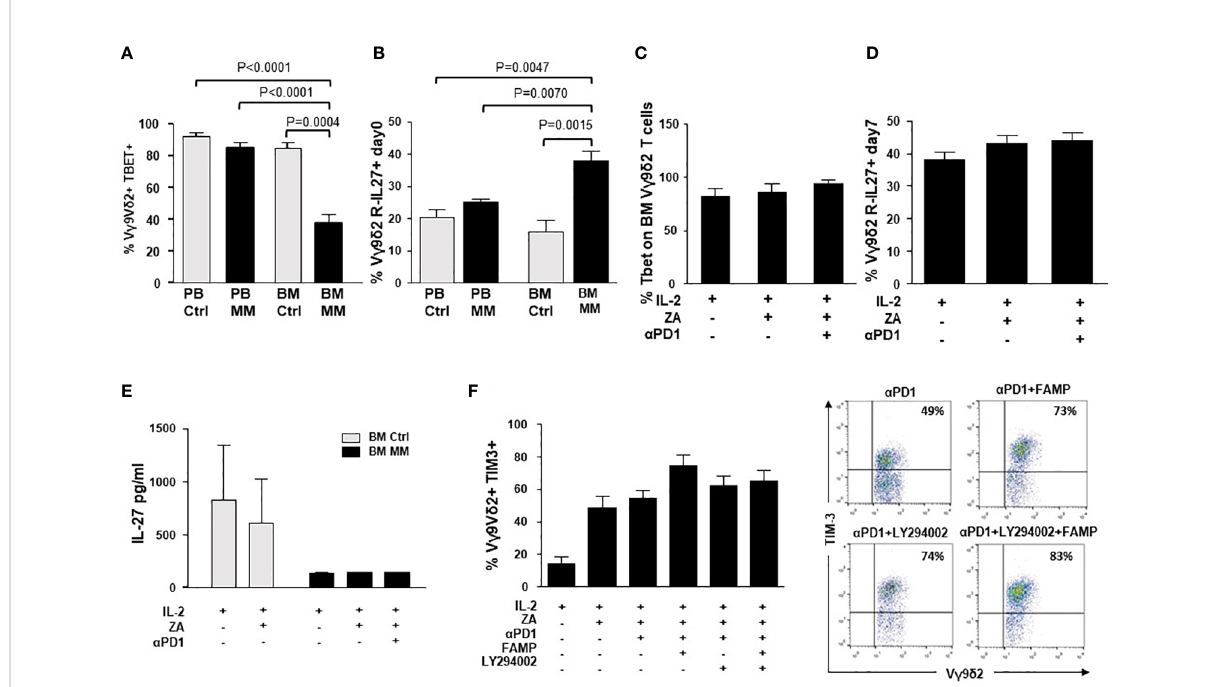
FIGURE 6 Intracellular PD-1/TIM-3 cross-talk is not mediated by the IL-27/pSTAT1/T-bet or PI3K-AKT axes. (A) T-bet and MFI expression in resting PB and BM Ctrl and MM V g 9V d 2 T cells. Bars represent the mean values ± SE from 6 (BM Ctrl) to 25 experiments (BM MM); (B) IL-27R expression in resting PB and BM Ctrl and MM V g 9V d 2 T cells. Bars represent the mean values ± SE from 6 (BM Ctrl) to 25 experiments (BM MM). (C) T-bet and (D) IL-27R expression in ZA-stimulated BM MM V g 9V d 2 T cells with or without a PD1. Bars represent mean values ± SE from 4 (Tbet) to 6 (IL- 27R) experiments (E) IL-27 concentrations in the supernatants (S/N) of ZA-stimulated BMMC from Ctrl and MM patients. Bars represent the mean values ± SE from 3 (BM Ctrl) to 4 experiments (BM MM). (F) Left : TIM-3 expression in ZA-stimulated BM MM V g 9V d 2 T cells without or with a PD1 in the presence of LY294002 (PI3K inhibitor), fl udarabine monophosphate (FAMP) (p-STAT1 inhibitor), and the combination thereof. Bars represent the mean values ± SE of 7 experiments. Right : cyto fl uorimetric analysis of TIM-3 expression in ZA-stimulated BM MM V g 9V d 2 T cells without or with a -PD-1 and PI3K and/or pSTAT-1 inhibitors from one representative